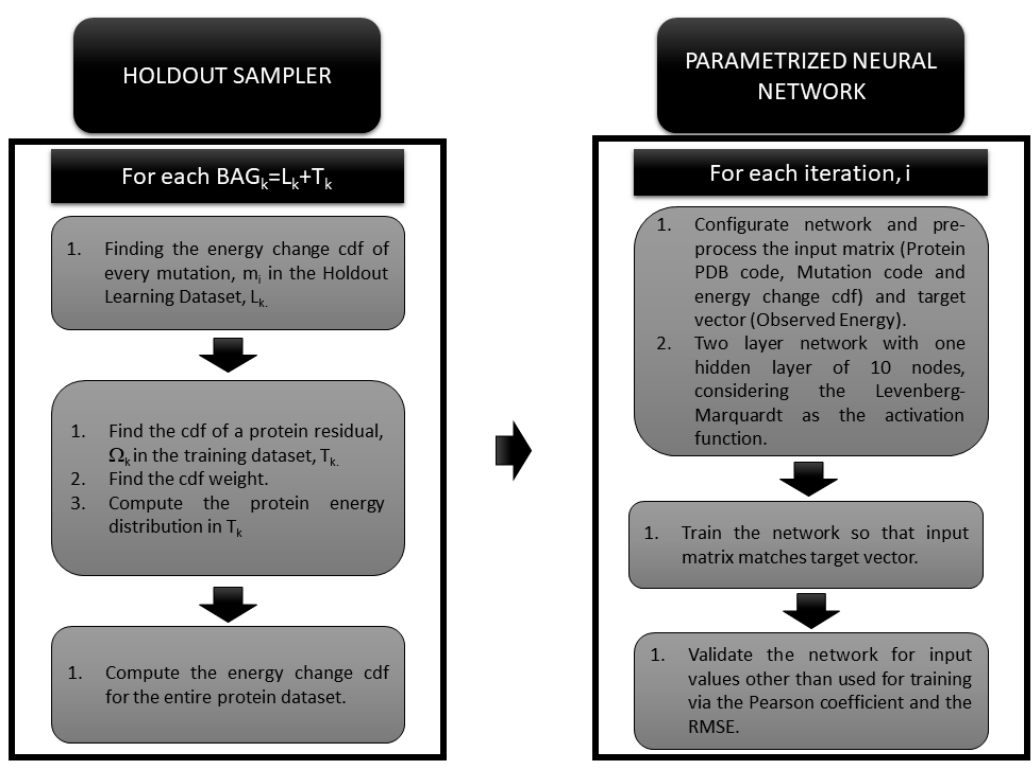
Figure 1. Workflow for the Prediction of Single Point Protein Mutation Energy Change and its Uncertainty.